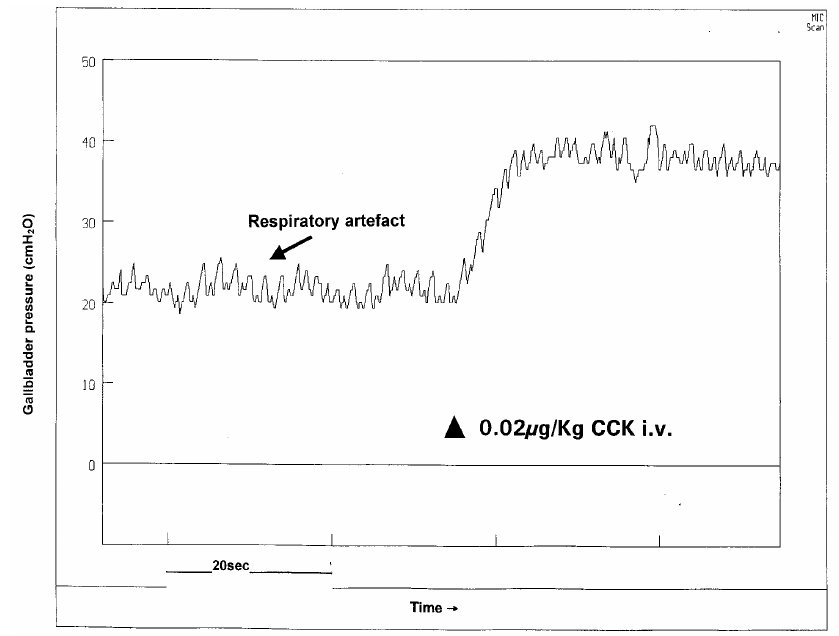
Fig. 6 Sample gallbladder pressure profile before and after 0.02 µ g/kg i.v. CCK-8 (21)